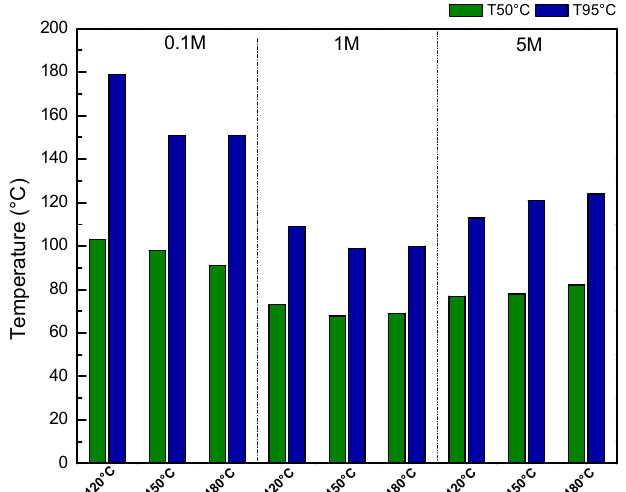
Figure 8. Temperatures of 50% (T 50 ) and 95% (T 95 ) of CO conversion for the CuCe oxide catalysts.